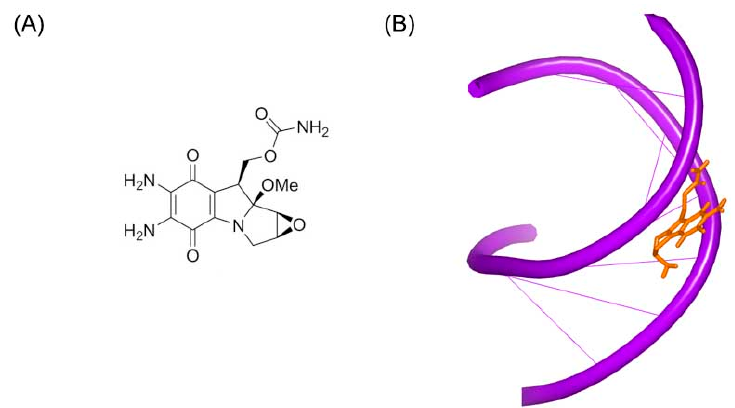
Figure 5. ( A ) Chemical structure of mitomycin C; and ( B ) crystal complex of a short DNA with mitomycin C (PDB code: 199D). The orange structure represents the small molecule; the purple structure represents the backbone of nucleic acid.